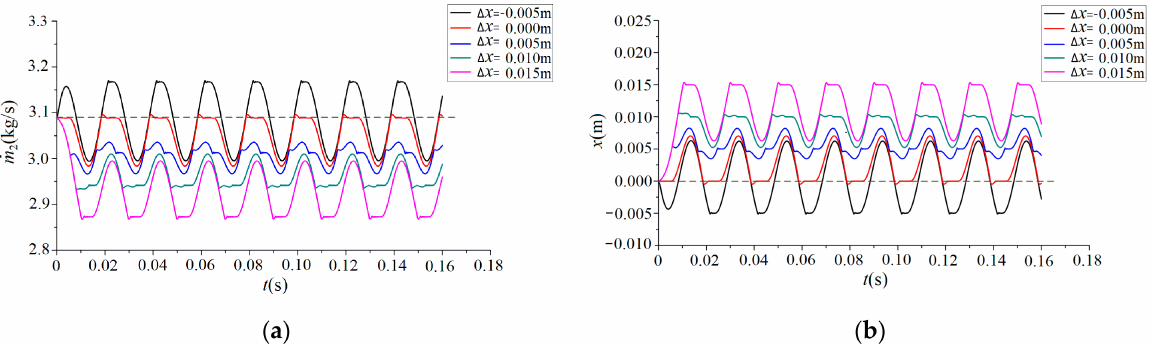
Figure 9. Parameter fluctuation with different positions when ξ = 6%. ( a ) Export flow. ( b ) Shock